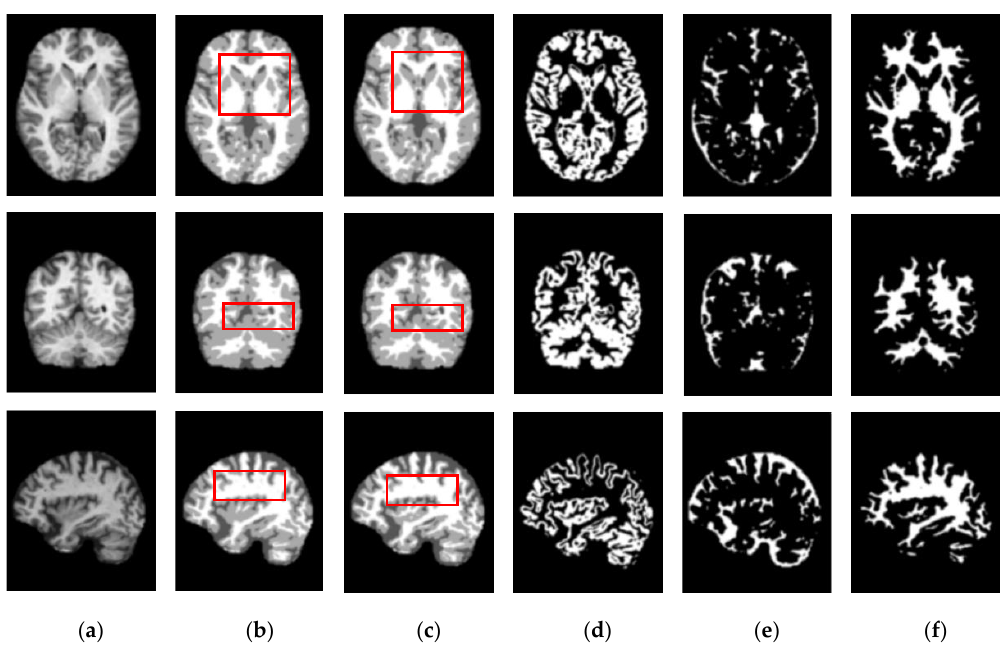
Figure 5. Segmentation results for the axial, coronal, and sagittal planes of the brain MRI image (top to bottom) on the OASIS dataset using the proposed method. ( a ) Original input images, ( b ) ground truth segmentation map, ( c ) their predicted segmentation map obtained by using the proposed method, ( d ) predicted GM (binary map), ( e ) predicted CSF (binary map), ( f ) predicted WM (binary map).